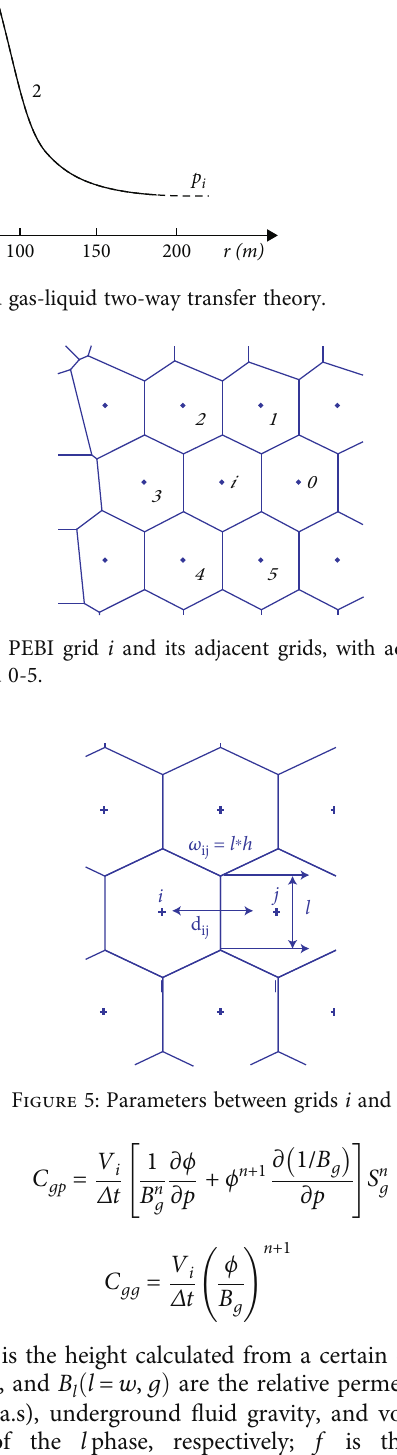
Figure 3: Model of a vertical-fractured well in rectangular-closed formation.